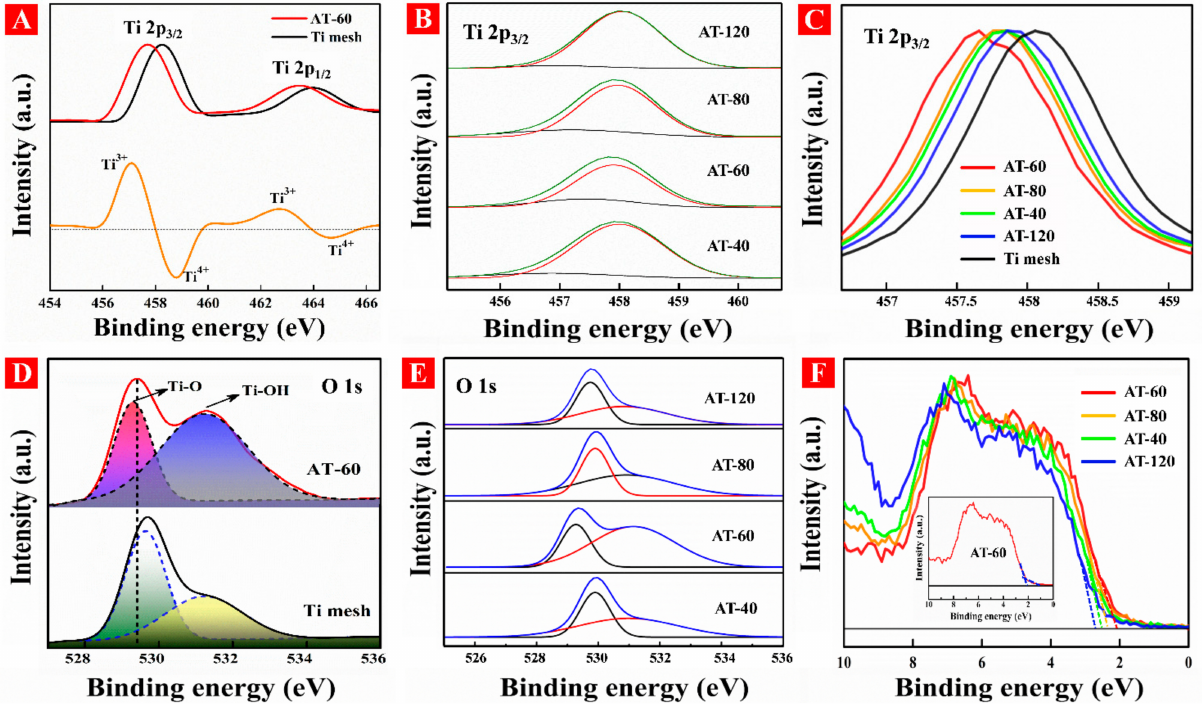
Figure 5. ( A ) Ti 2p spectra of AT-60 and Ti mesh. ( B ) Ti 2p 3/2 spectra and ( C ) its enlarged view for all samples. ( D ) O 1s spectra of AT-60 and Ti mesh, and ( E ) the deconvoluted O 1s for all samples. ( F ) the valence band state spectra for all samples. Table 1. The parameters including bandgap, valence band maximum (VBM), and relative ratio of Ti 3+ /Ti 4+ .